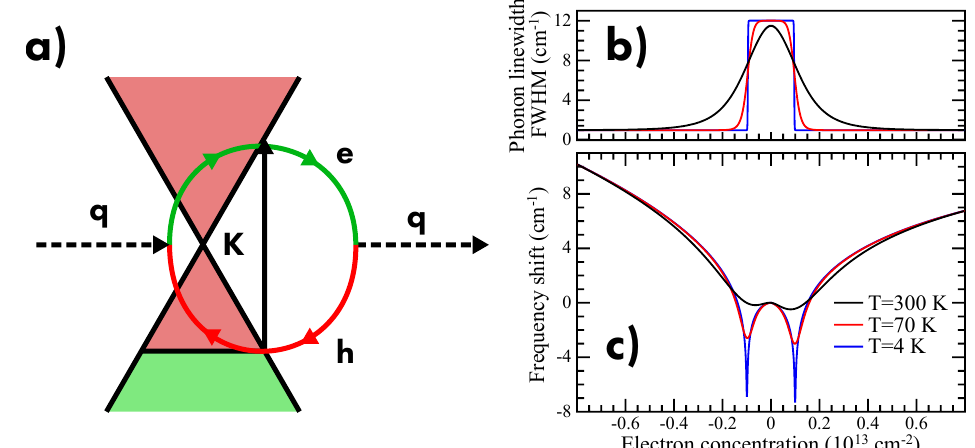
Figure 25. ( a ) Interaction between phonon and virtual electron-hole pair. Modification of ( b ) bandwidth ( c ) peak frequency for G band on varying doping. Adapted with permission from Ref. [101]. Copyright (2006) American Physical Society.